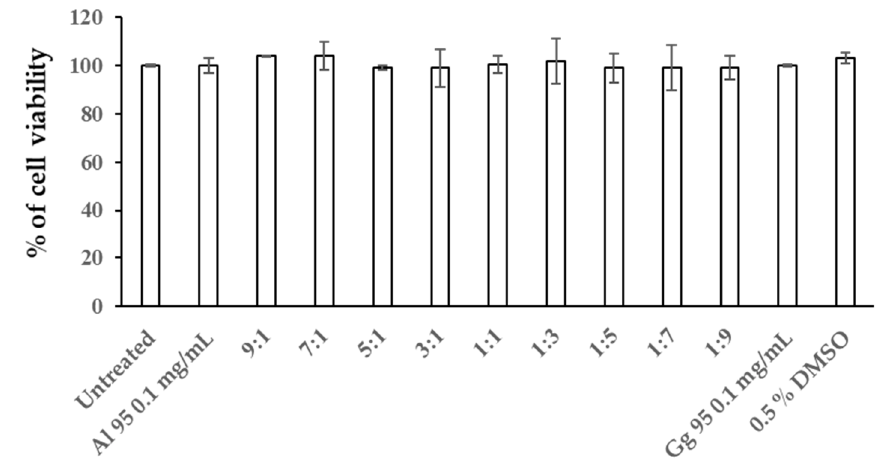
Figure 4. Cell viability of B16 cells exposed to mixtures of A. lakoocha and G. glabra extracts. Cells were treated with the combination of Al95 and Gg95 extracts for 72 h. Percentages of cell viability are means ± SD from three independent experiments.